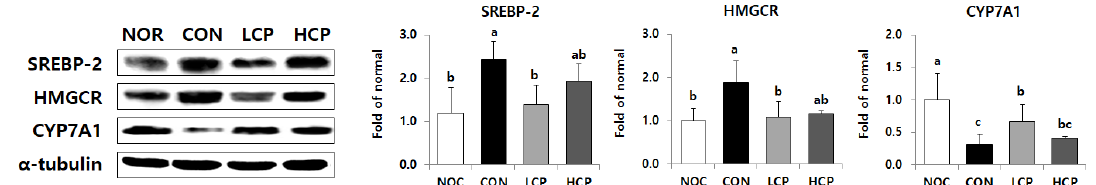
Figure 6. Effects of two skate skin-derived collagen peptides with different molecular weights on hepatic protein expression of cholesterol metabolism. Data are mean ± standard deviation (SD) ( n = 10 per group). Experimental groups were divided into four groups; m/m mice were orally administered water as a vehicle (NOR group) whereas db/db mice were orally administered water (control group, CON), LCP (LCP group), or HCP (HCP group) at a dose of 200 mg·kg bw −1 ·day −1 for 8 weeks. a–-c Different letters mean significant differences to one-way analysis of variance (ANOVA), followed by Duncan’s multiple-range test at p < 0.05.